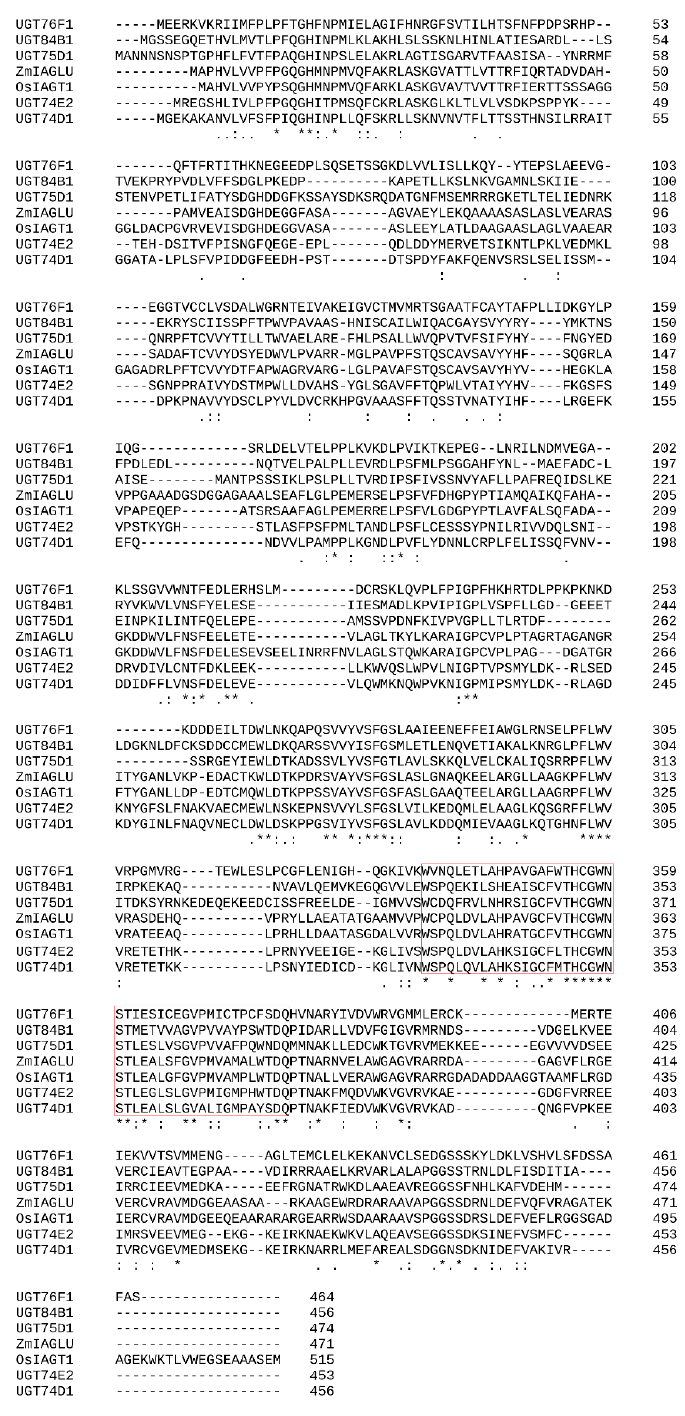
Figure 10. Sequence alignment of IAA glucosyltransferases: maize IAGlc synthase (ZmIAGLU, NCBI Reference Sequence Database, accession number NP_001105326.1), rice OsIAGT1 (GenBank, accession number BAS85861.1) and A. thaliana glucosyltransferases UGT74D1 (UniProtKB/Swiss- Prot, accession number Q9SKC5.1), UGT74E2 (GenBank, accession number ABJ17124.1), UGT75D1 (UniProtKB/Swiss-Prot, accession number O23406.2), UGT76F1 (UniProtKB/Swiss-Prot, accession number Q9M051.1) and UGT84B1 (GenBank, accession number AAO63432.1). The red box indicates the PSPG motif. The sequence alignment was generated using Clustal Omega.